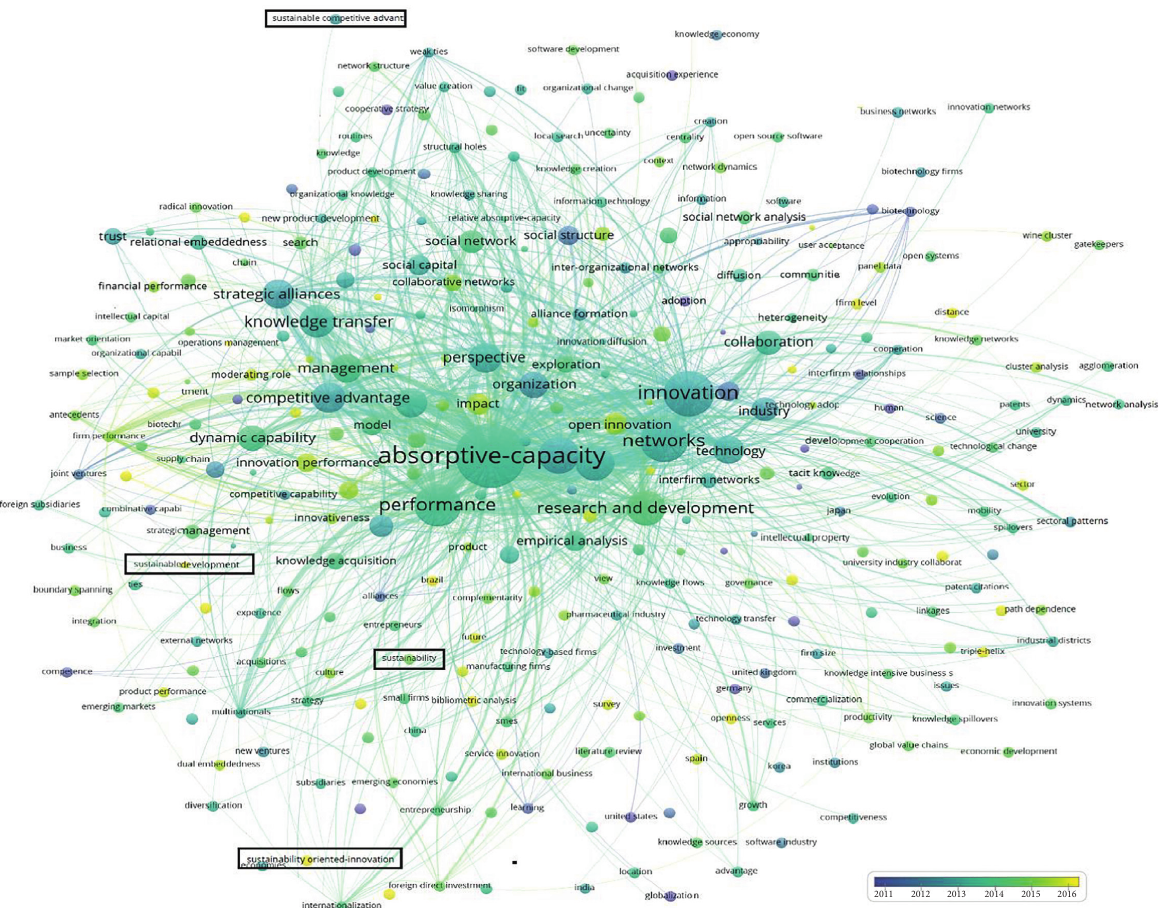
Figure 12: Temporal evolution of keywords network. Source: own elaboration with Web of Science and Scopus data (2018) processed with VOSviewer